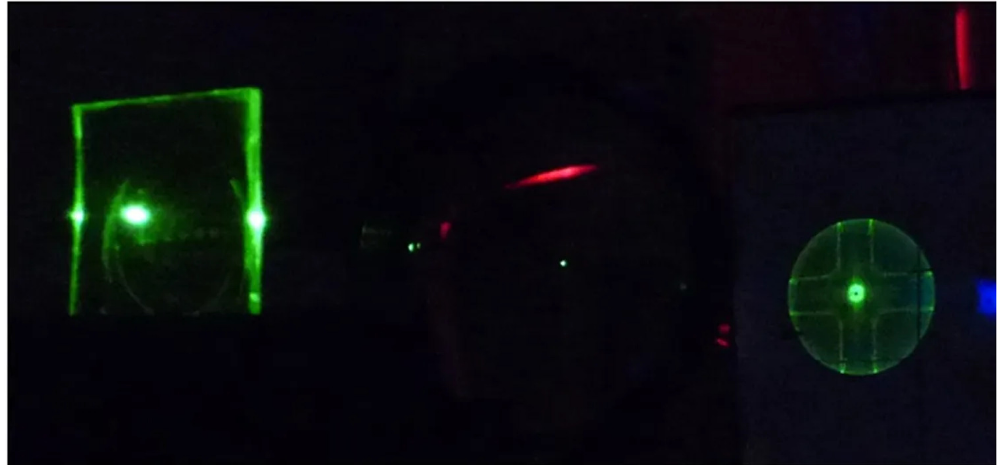
Figure 13. Photograph of a MAPbBr 3 DFB laser above the lasing threshold. Adapted with